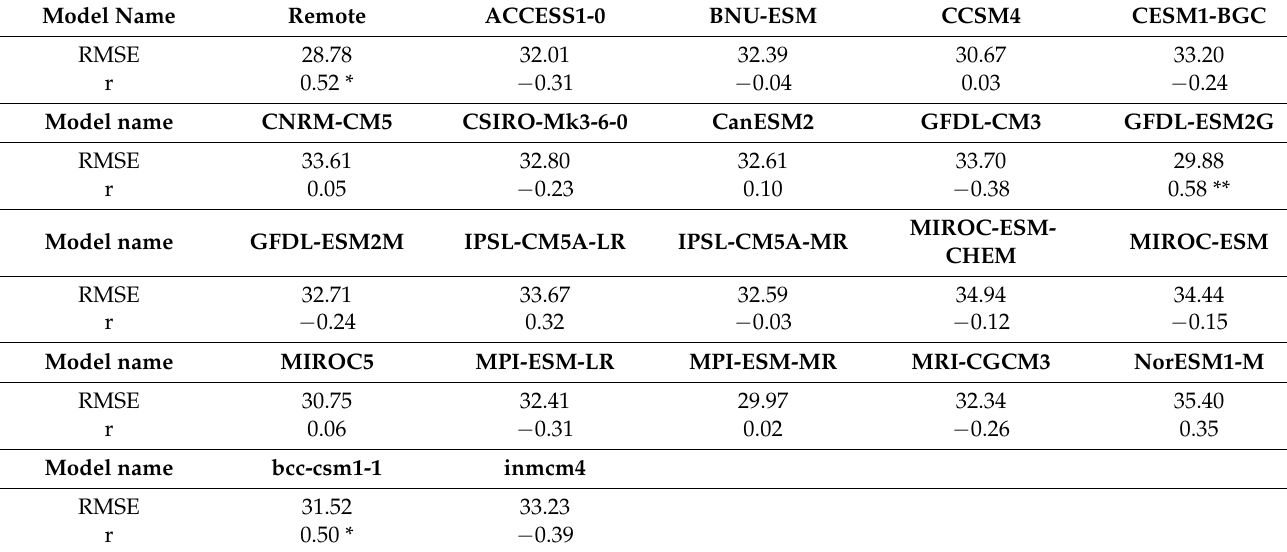
Figure 12. Temporal changes in annual cumulative snow depth during 1986–2005 as derived from observations, NEX-GDDP, and remote sensing data over China. Table 3. RMSE & r between the two sets of simulations and observed snow depth